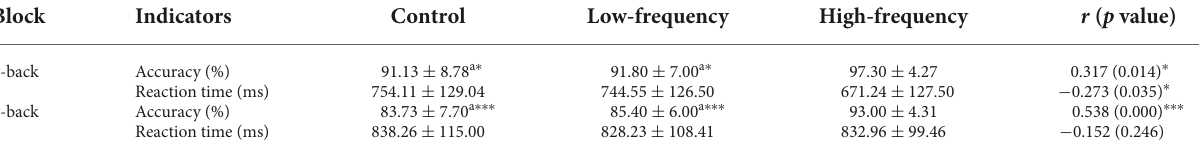
TABLE 4 The accuracy and reaction time of the N-back Task in each group (Mean ± SD). Block